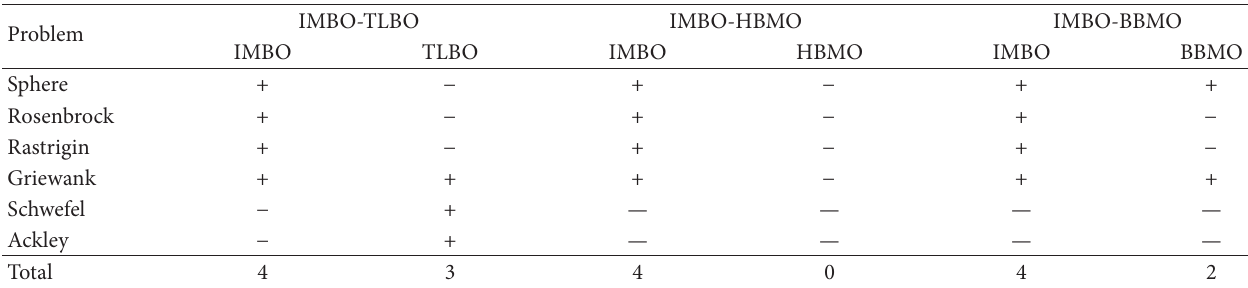
Table 10: Comparative results of IMBO with TLBO, HBMO, and BBMO algorithms over 30 independent runs for genotype size 50. + indicates that the algorithm is better while − indicates that it is worse than the other, (—): not available value. If both algorithms show similar performance, they are both +.